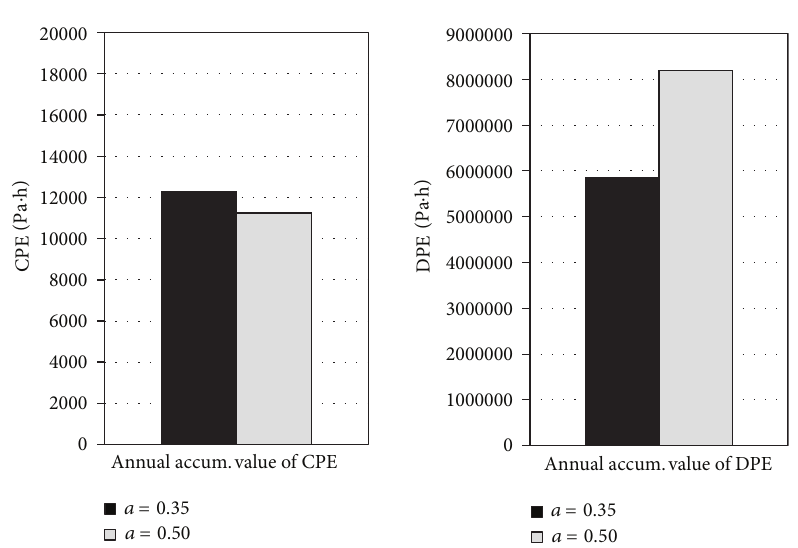
Figure 12: Properties of the exterior layer: absorbance to solar